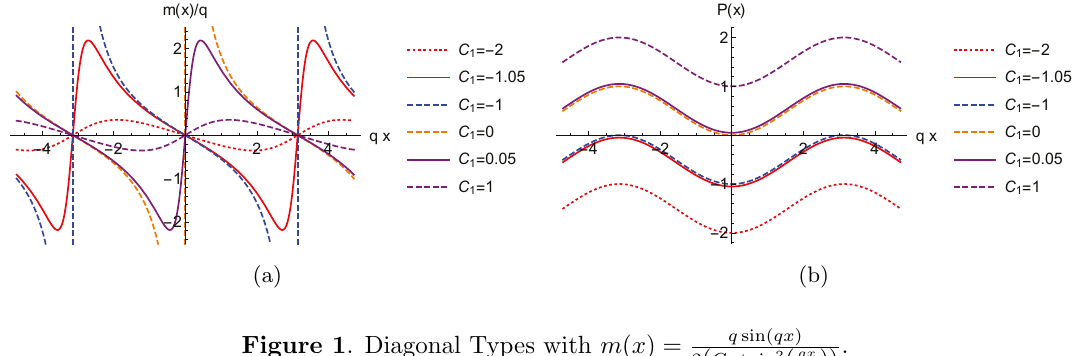
Figure 1 . Diagonal Types with m ( x )